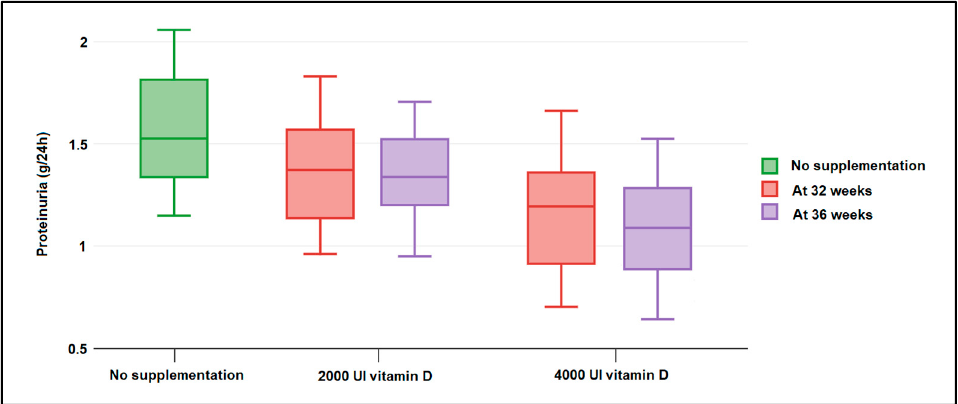
Figure 1. Boxplot of maternal proteinuria (g/L) measured at 32 and 36 weeks of gestation and stratified by nutritional supplementation with 2000 UI and 4000 UI of vitamin D. Data analyzed by Kruskal–Wallis test.